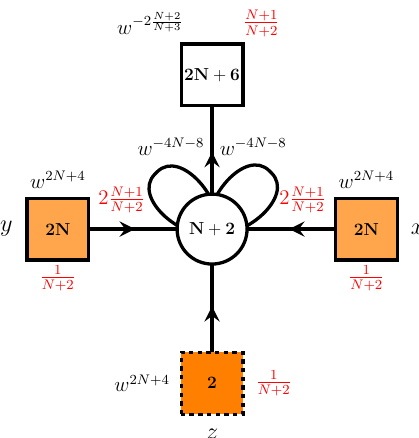
Figure 21: A trinion with two maximal USp ( 2 N ) punctures and a minimal SU ( 2 ) puncture. Note that the two maximal punctures are of the same type (color). More- over, following the logic of [ 38 ] gluing together N such trinions, the N minimal punctures will recombine into an USp ( 2 N ) maximal puncture somewhere on the conformal manifold. Such a theory then will have tree maximal USp ( 2 N ) punctures all of which are of the same color. For N = 1 this theory is asymptotically free. For N = 2 the gauge and superpotential interactions are marginally irrelevant. The theory has a U ( 1 ) symmetry, such that the fundamentals have charge + 1 and the